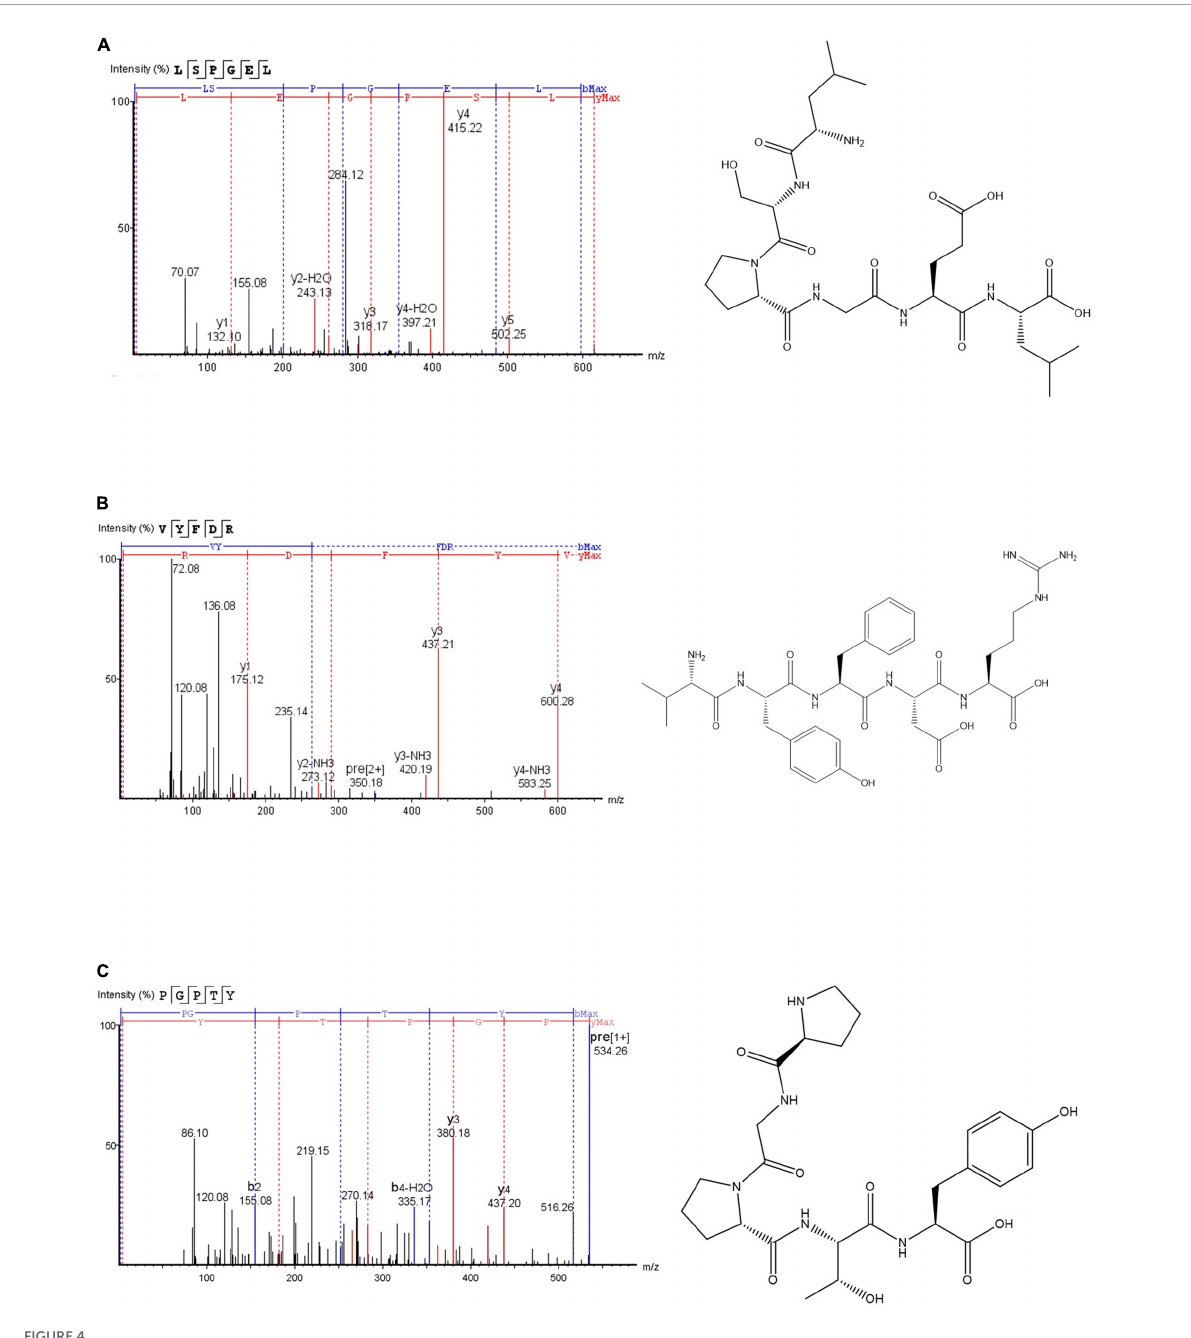
FIGURE4 Secondary mass spectra and chemical structures of LSPGEL (A) , VYFDR (B) , and PGPTY (C)